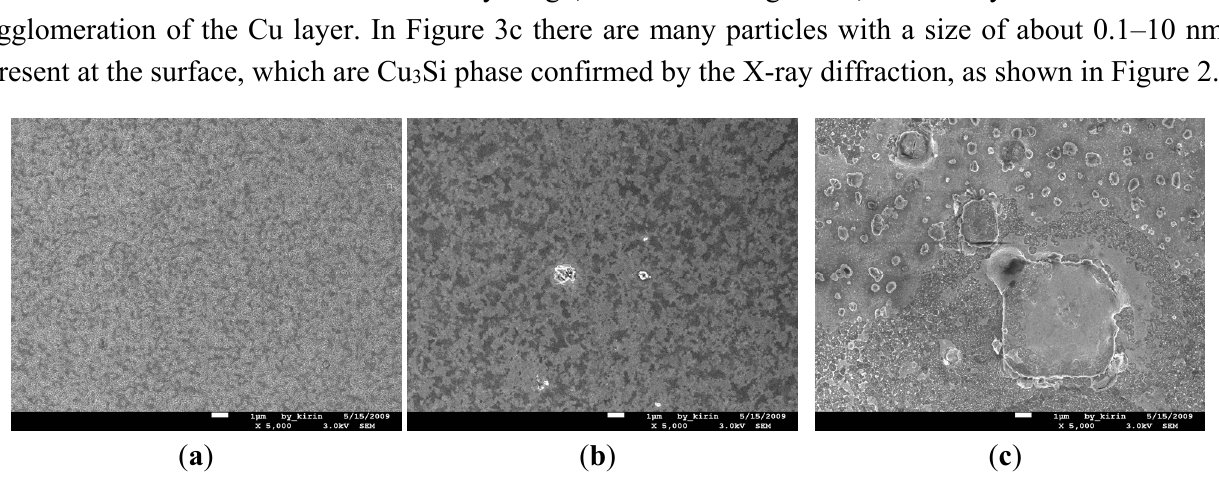
Figure 3. Scanning electron microscope (SEM) views for the surface morphologies of MgO (3 nm) sample annealed for 5 min at temperatures of 700 °C ( a ); 750 °C ( b ); and 800 °C ( c );